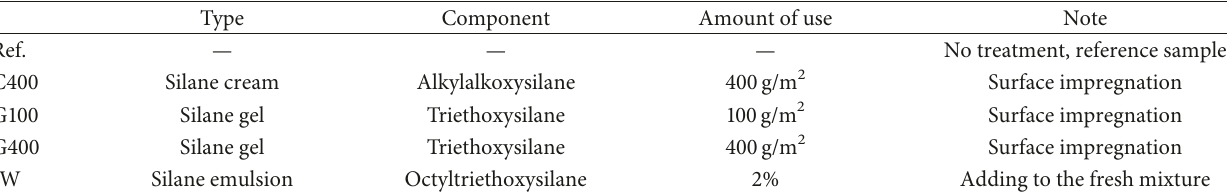
Table 2: The type of water repellent agents used in this project and their amounts.